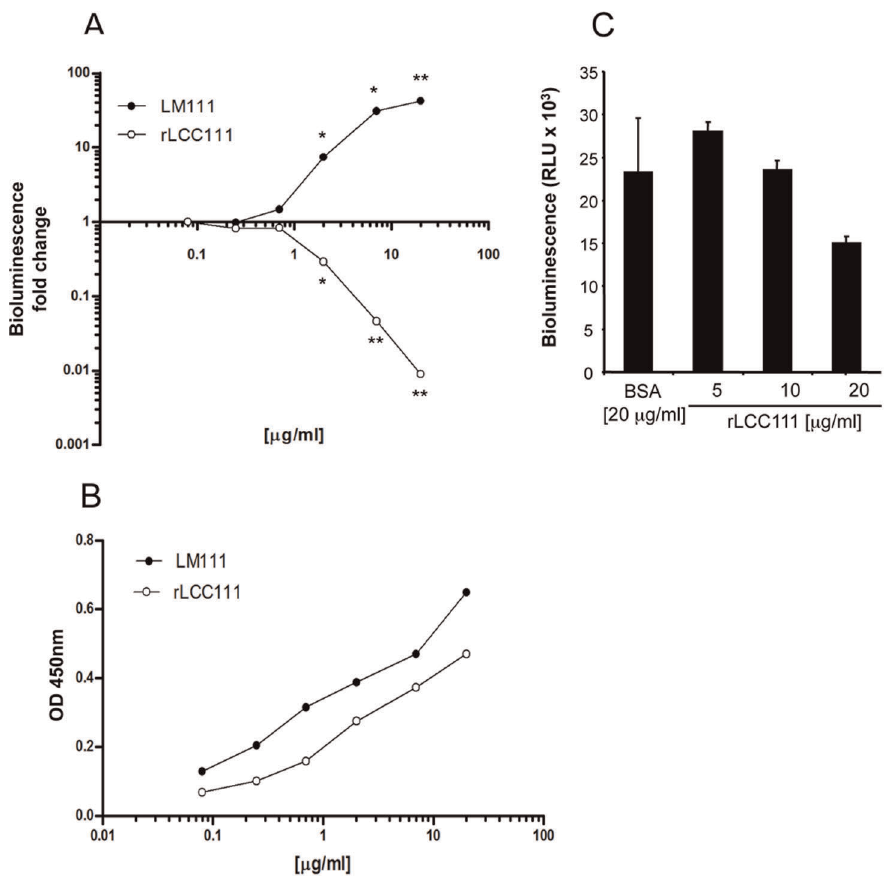
Figure 4. rLCC111 substrates do not support cell attachment. Adhesion of HT0180 cells to plastic-coated LM111 or rLCC111 (ranging from 0.08 to 20 m g/ml), or BSA was measured by bioluminescence. (A). Data are plotted as the log of fold change in adhesion relative to BSA. The coating efficiency of LM111 and rLCC111 was monitored by ELISA using a polyclonal anti-laminin antibody (B). Soluble rLCC111 (5 to 20 mg/ml) inhibits adhesion of HT1080 cells (C) to plastic immobilized intact LM111 (10 mg/ml). Data shown are from a representative experiment out of three independent ones. (*, p , 0,05; **, p , 0,005).